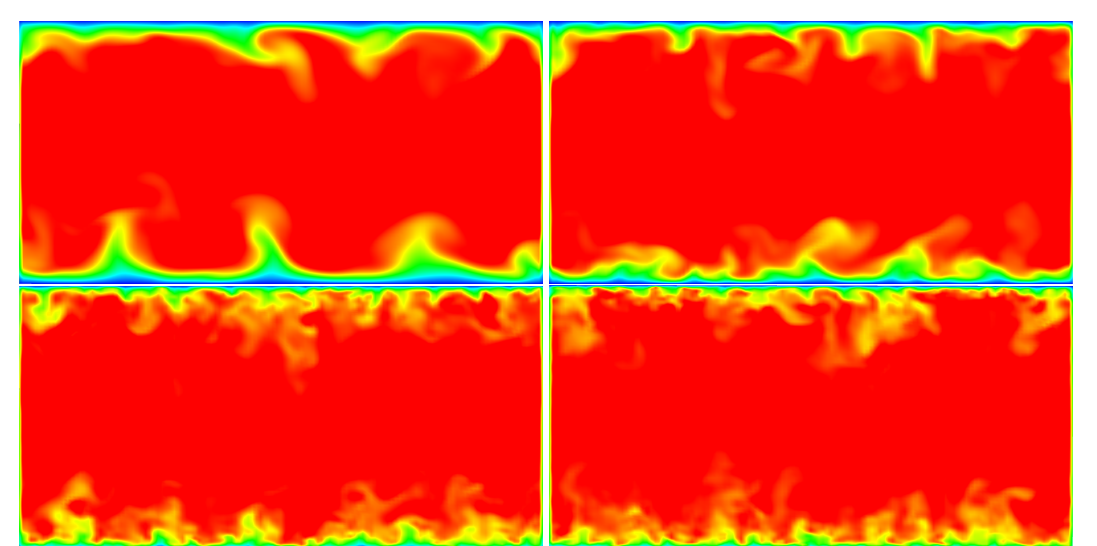
Figure 5. Fluid flow snapshots of streamwise velocity via 2D graphs in the Z − Y plane, from top to bottom: m = 0, Re = 3300; m = 0.9, Re = 3300; m = 0, Re = 13,800 and m = 0.9, Re = 13,800. Contour levels: 0;0.1;1.